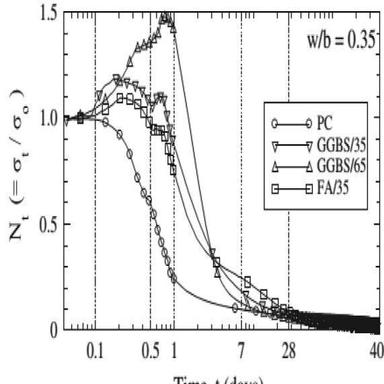
Temporal changes in conductivity (a) and normalized conductivity (b) values. (at 75 mm) over test period for concrete mixes and (c) schematic diagram of the four stages shown in (a) and (b).